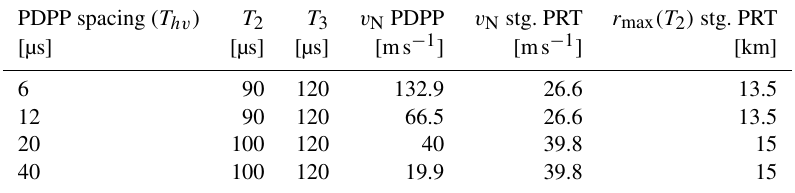
Table 2. PDPP operation modes. Aircraft manoeuver Antenna Description Incidence angle ( ◦ ) Horizontal transects Aft antenna + reflector Data collection at different beam angles obtained by changing the reflector posi- tion while the aircraft maintains a con- stant altitude. Orbits Aft + reflector Aft-looking beam is redirected to nadir view via the reflector. Change in aircraft roll angles from [0 to 40 ◦ ]. Side Change in aircraft roll angles from 0 to 45 ◦ . Roll sweeps Aft + reflector Aft-looking beam is redirected to nadir view via the reflector. Change in aircraft roll angles from [ − 40 to − 40 ◦ ]. Table 3. PRT selection for PDPP modes. PDPP spacing ( T hv